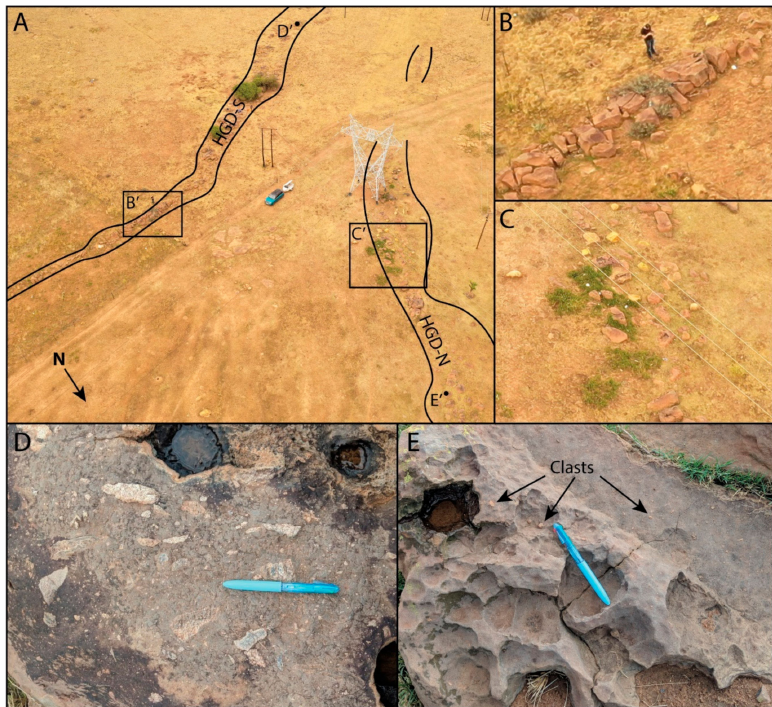
Figure 4. Southwest-facing unmanned aerial vehicle (UAV) image showing disaggregate and ag- gregate characteristics of the HGD-N and HGD-S dike segments, respectively. Bounding black lines of the dike segments roughly indicate the dike margins. ( A ) Note the car and trailer for scale. ( B ) Referencing inset B’ on HGD-S showing a characteristic compact dike segment. The width of the dike was ≈ 2–3 m. Note the person for scale. ( C ) Referencing inset C’ on HGD-N showing a characteristic disaggregated dike segment. The width of the dike at this section was ≈ 6 m and this inset was diagnostic of the segment. ( D ) Referencing point D’ in A, which is a photo of large angular clasts in the matrix of HGD-S. ( E ) Referencing point E’ in A, a photo of small clasts in the matrix of HGD-N. Note the prominent erosional pits. In images D and E, note the pen (14 cm) for scale. Structural markers in the granites were scarce in the area due to limited